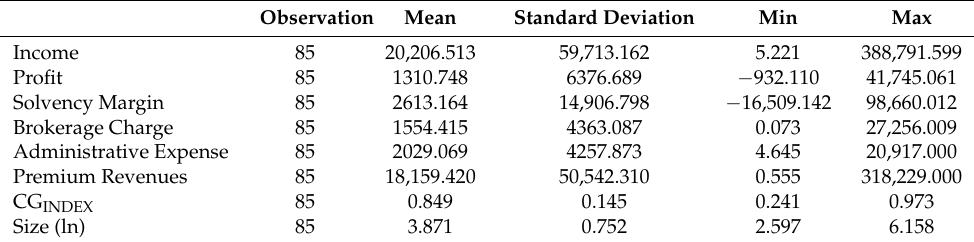
Table 2. Summary statistics of the main variables (million